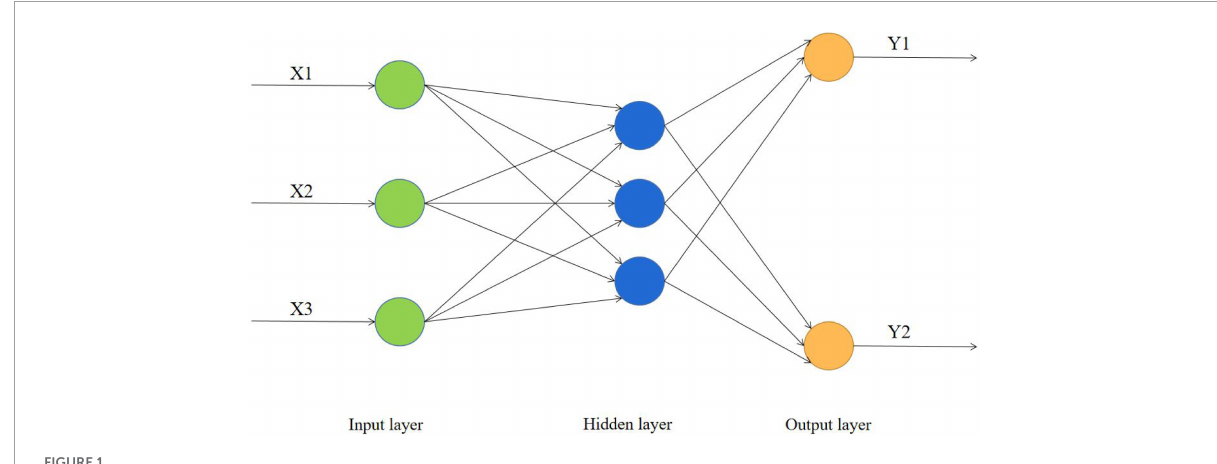
FIGURE1 BP neural network algorithm